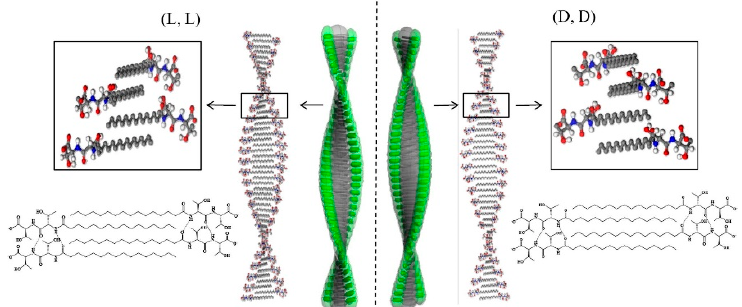
Figure 3. Mechanism of formation of helical structures for (L, L) and (D, D) threonine. Reprinted with permission from [34], Copyright Elsevier.